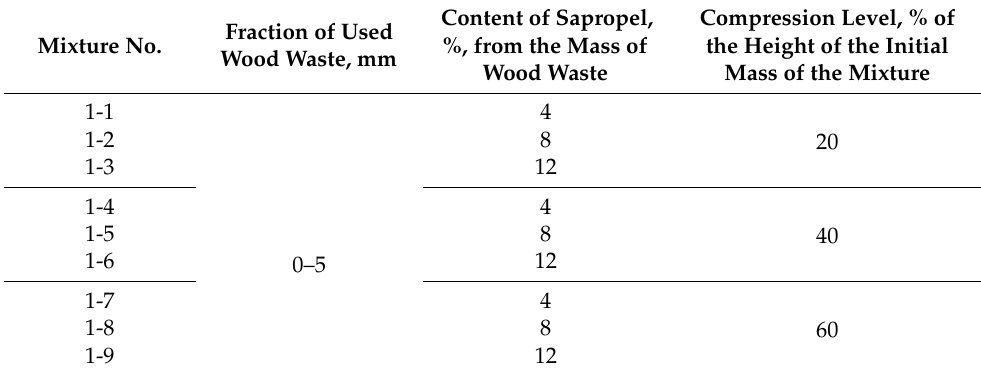
Table 3. The composition of the forming mixtures and their compression levels.